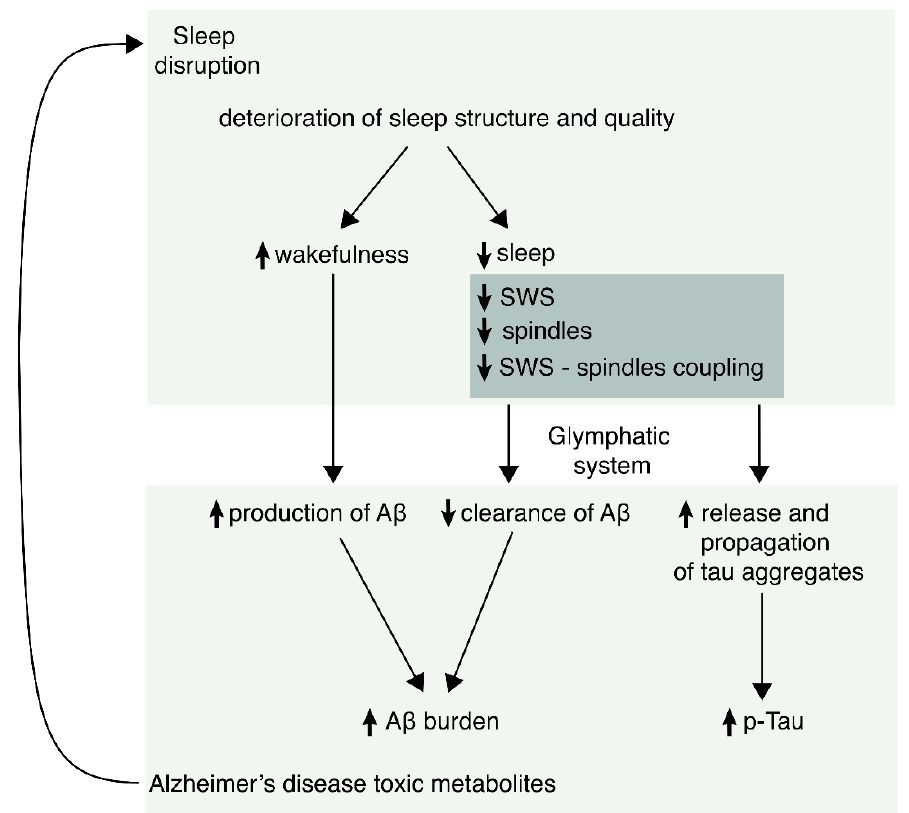
Figure 2. Schematic rendition summarizing the possible sleep biomarkers in AD. Experimental evidence suggests that sleep disorders appear early in AD. Sleep abnormalities induce more formation of pathological tau and beta-amyloid peptide (A β ). Likewise, both A β and P-tau induce sleep disorders, generating a positive feedback process.